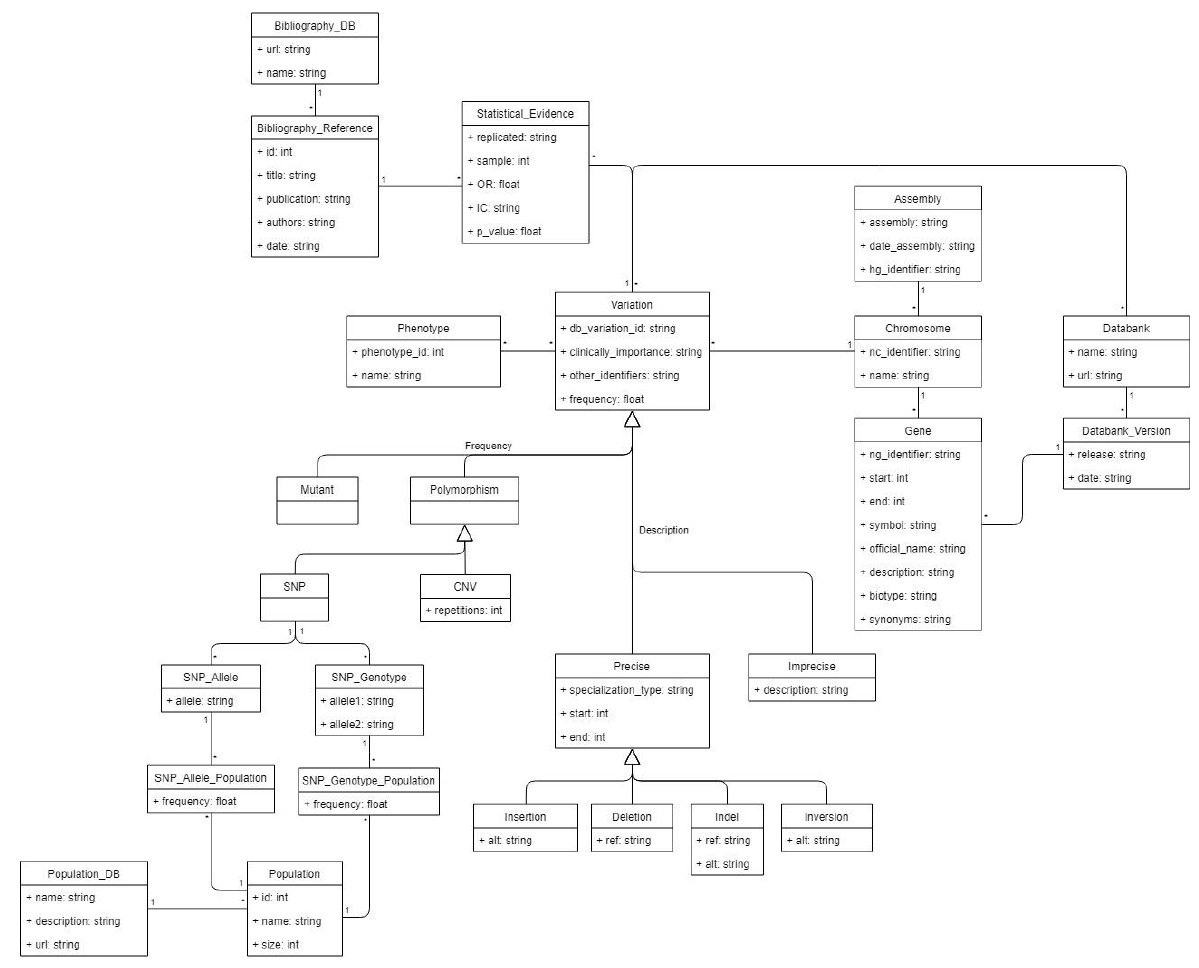
Figure 4. Representation of a DNA variation based on the